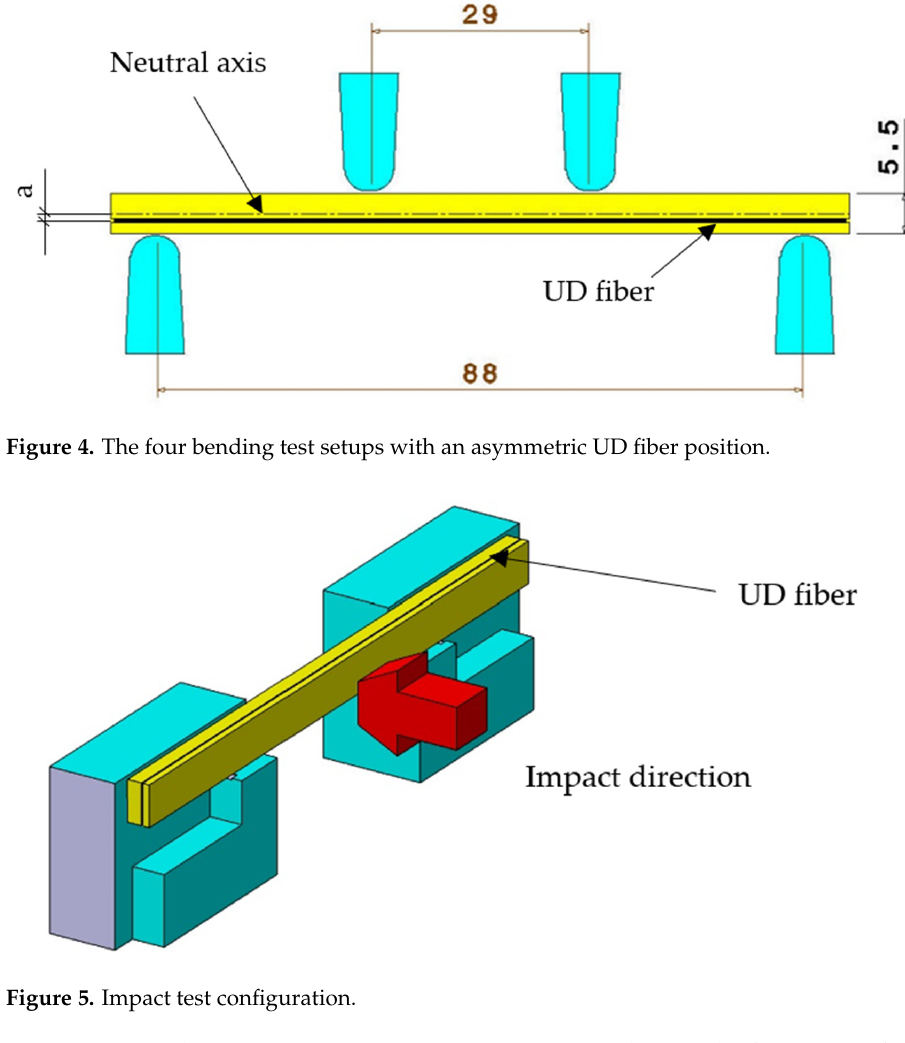
Figure 4. The four bending test setups with an asymmetric UD fiber position.